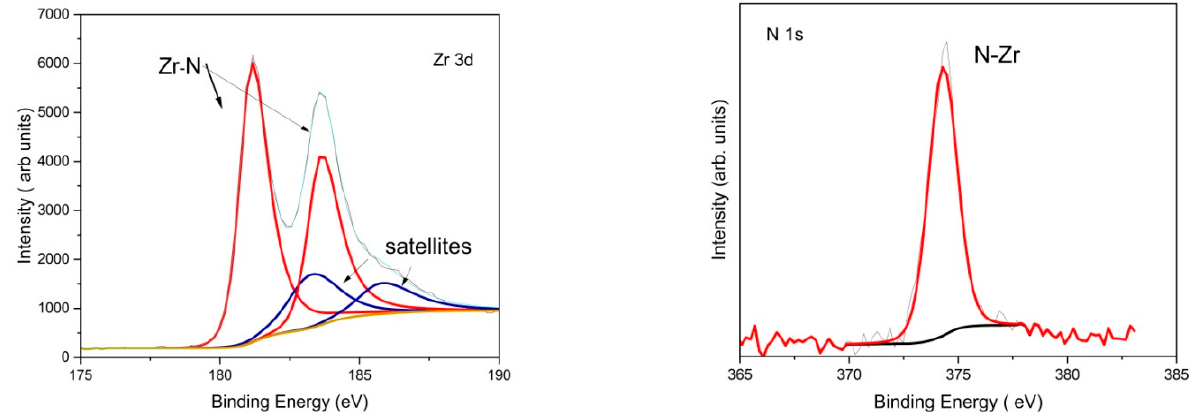
Figure 3. Peak fitting results for Zr3d and N 1s high resolution (HR) fitted spectra, for level 2 of sample A.